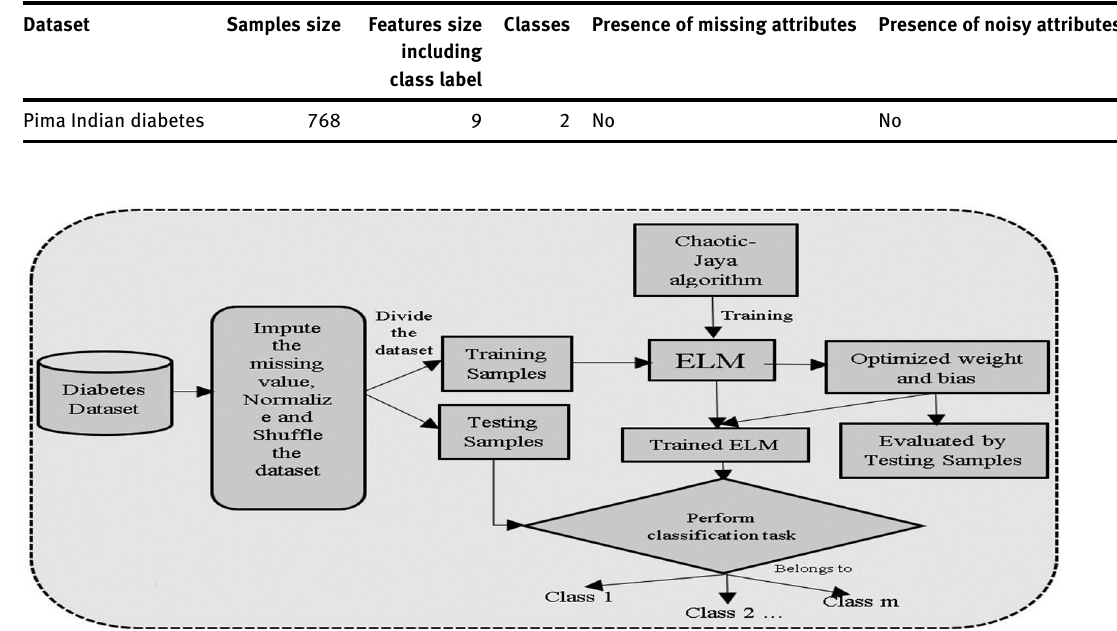
Table  : Description of the Pima Indian diabetes datasets.